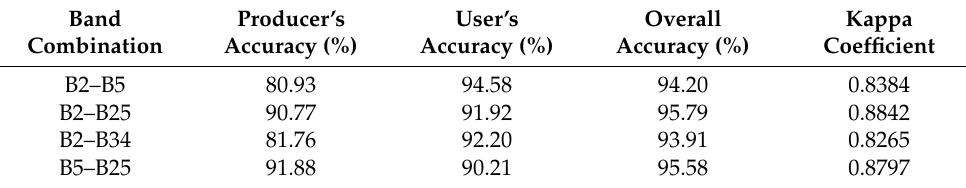
Table 2. Quantitative comparison of the results of different band